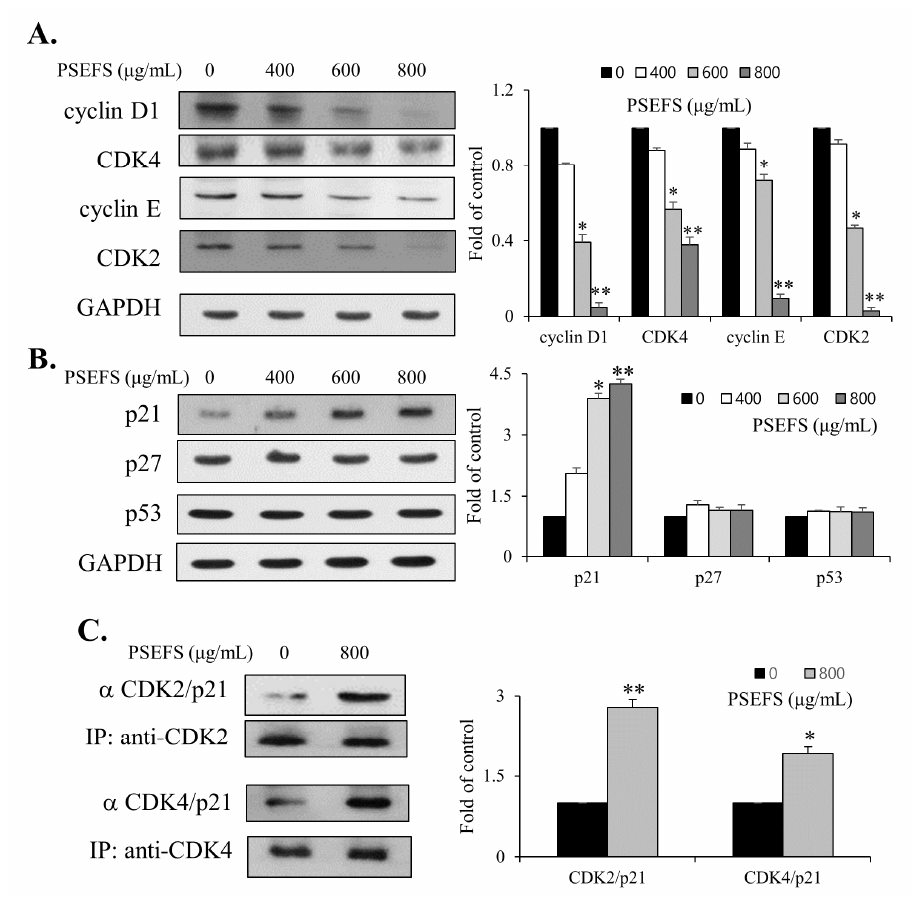
Figure 2. Involvement of cell cycle regulators in PSEFS-mediated cell cycle arrest at the G1 phase. ( A , B ) Immunoblot images of CDK4, cyclin D1, CDK2, cyclin E, p21 WAF1 , p53, and p27 KIP1 after treatment of T24 cells with PSEFS for 24 h. GAPDH was used as an internal control. ( C ) Cell lysates were immunoprecipitated with anti-CDK4 and anti-CDK2 antibodies, followed by immunoblot with the anti-p21 WAF1 antibody. Data represent the mean ± SD of triplicate experiments. * p < 0.05, ** p < 0.01 vs. control.